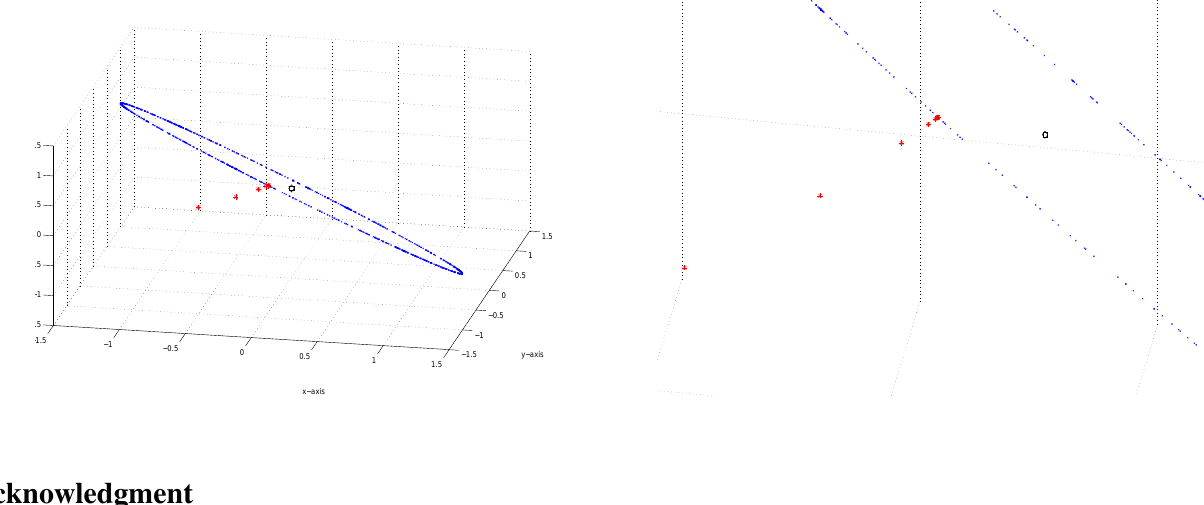
(Left) Example of convergence to set of fixed points, (Right) Close-up of